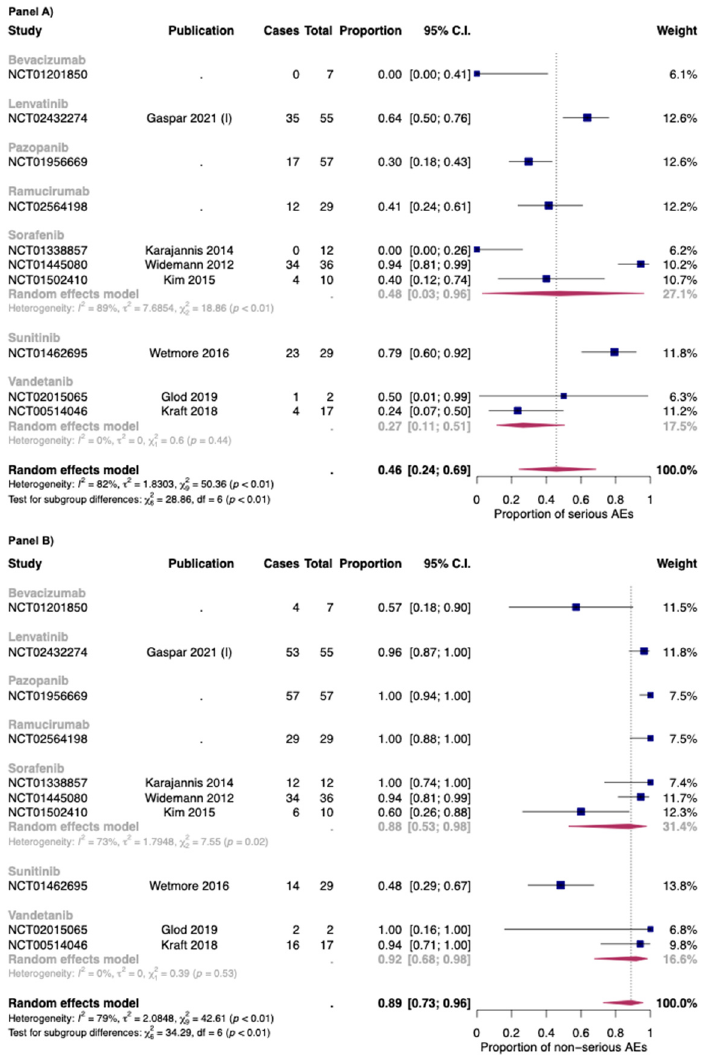
Figure 3. Overall proportion of serious (Panel A ) and non-serious (Panel B ) AEs for anti-angiogenic drugs used as monotherapy. Cases: Patients with at least an event. Total: Patients included in the study [35,42,47,49,70,71,90].